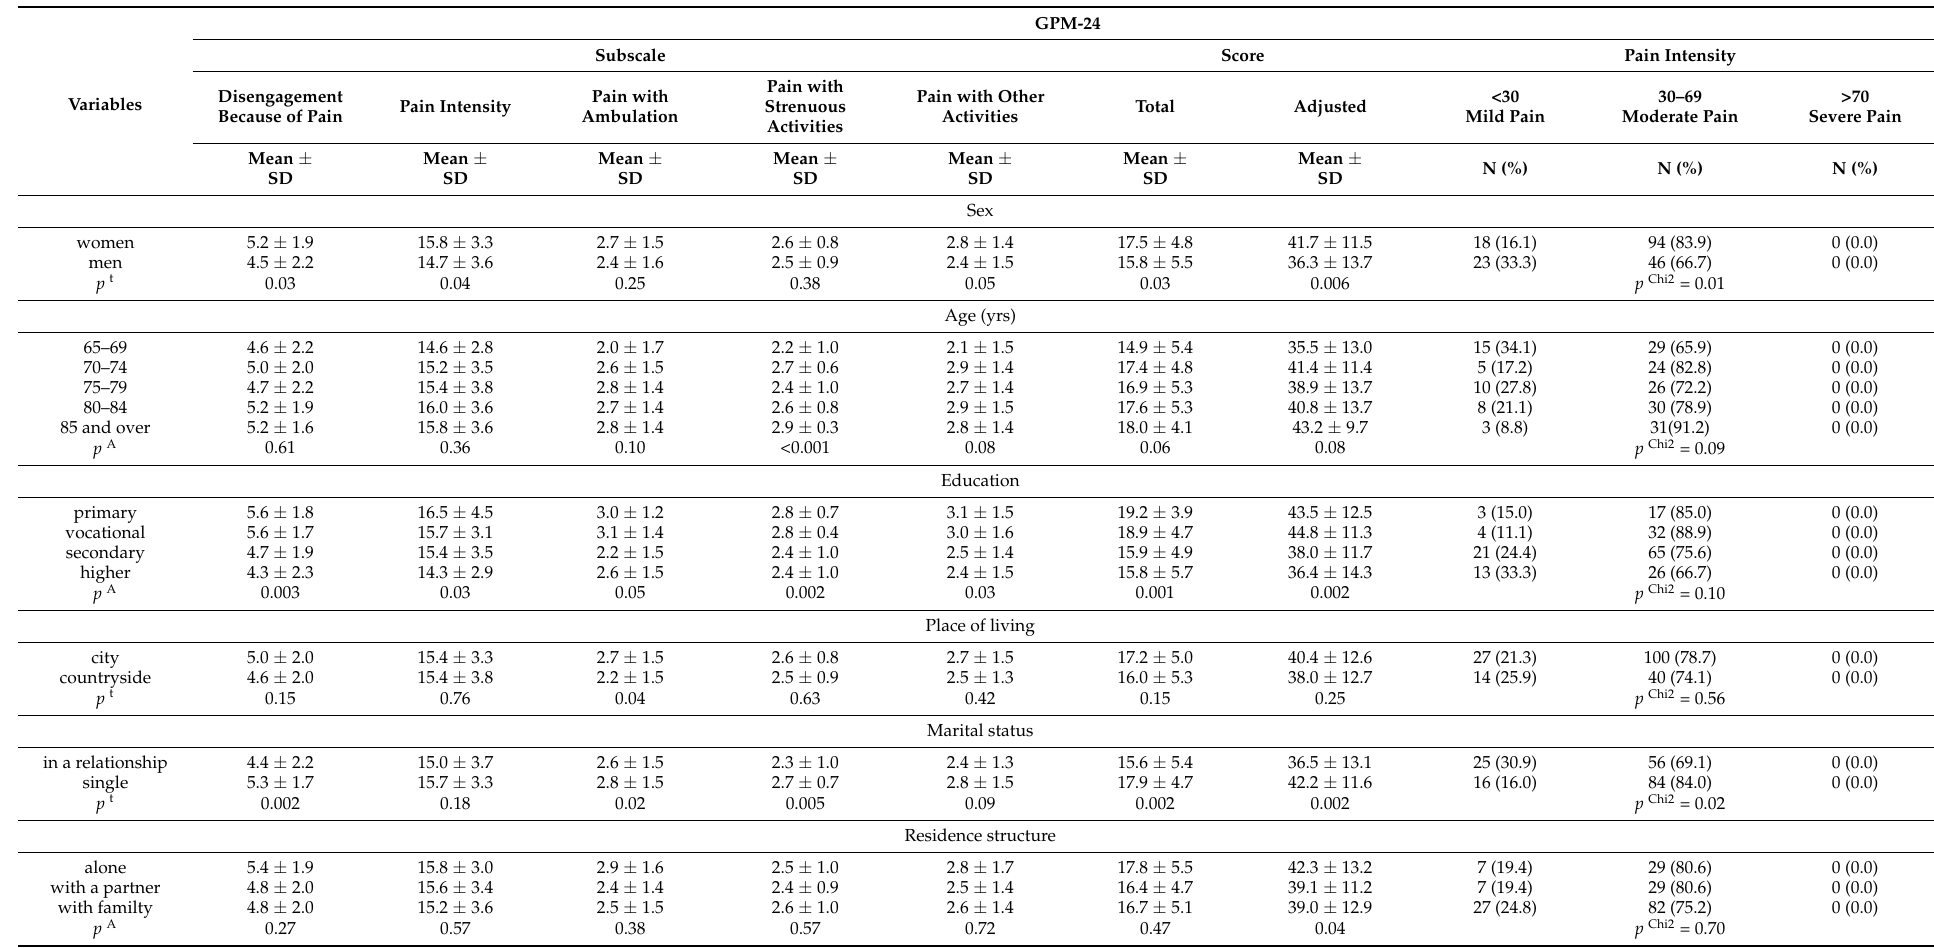
Table 2. Demographic and social variables determine the functional capacity of people with chronic